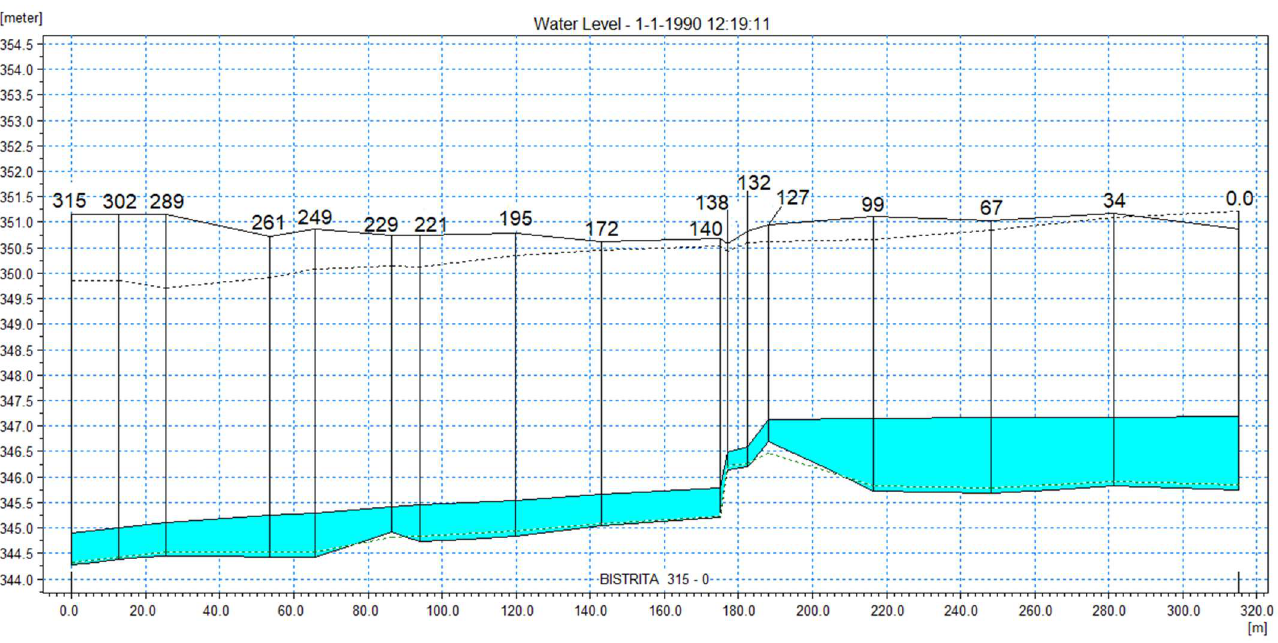
Figure 8. Water level for flow Q = 8.37 m 3 /s, the average annual flow calculated for the year 2021. For the case where there is only one weir, the existing one. In Figure 9, there is the speed of the water in the longitudinal profile for Q = 8.37 m 3 /s